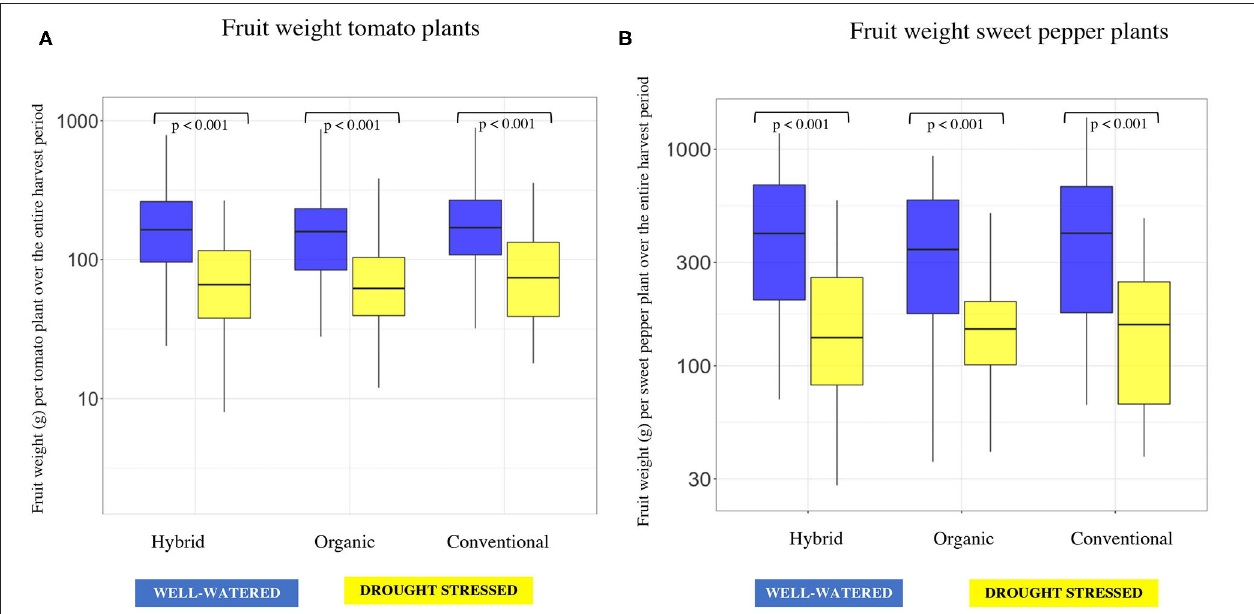
FIGURE 3 | Comparison of fruit weight in grams per plant on average over the entire harvest period between the hybrid, organic, and conventional groups for tomato (A) and sweet pepper plants (B) under well-watered conditions and drought stress. Differences between treatments were significant equally for tomato and sweet pepper ( p < 0.001). Each boxplot shows median (line within the box), lower and upper quartile (box), and range